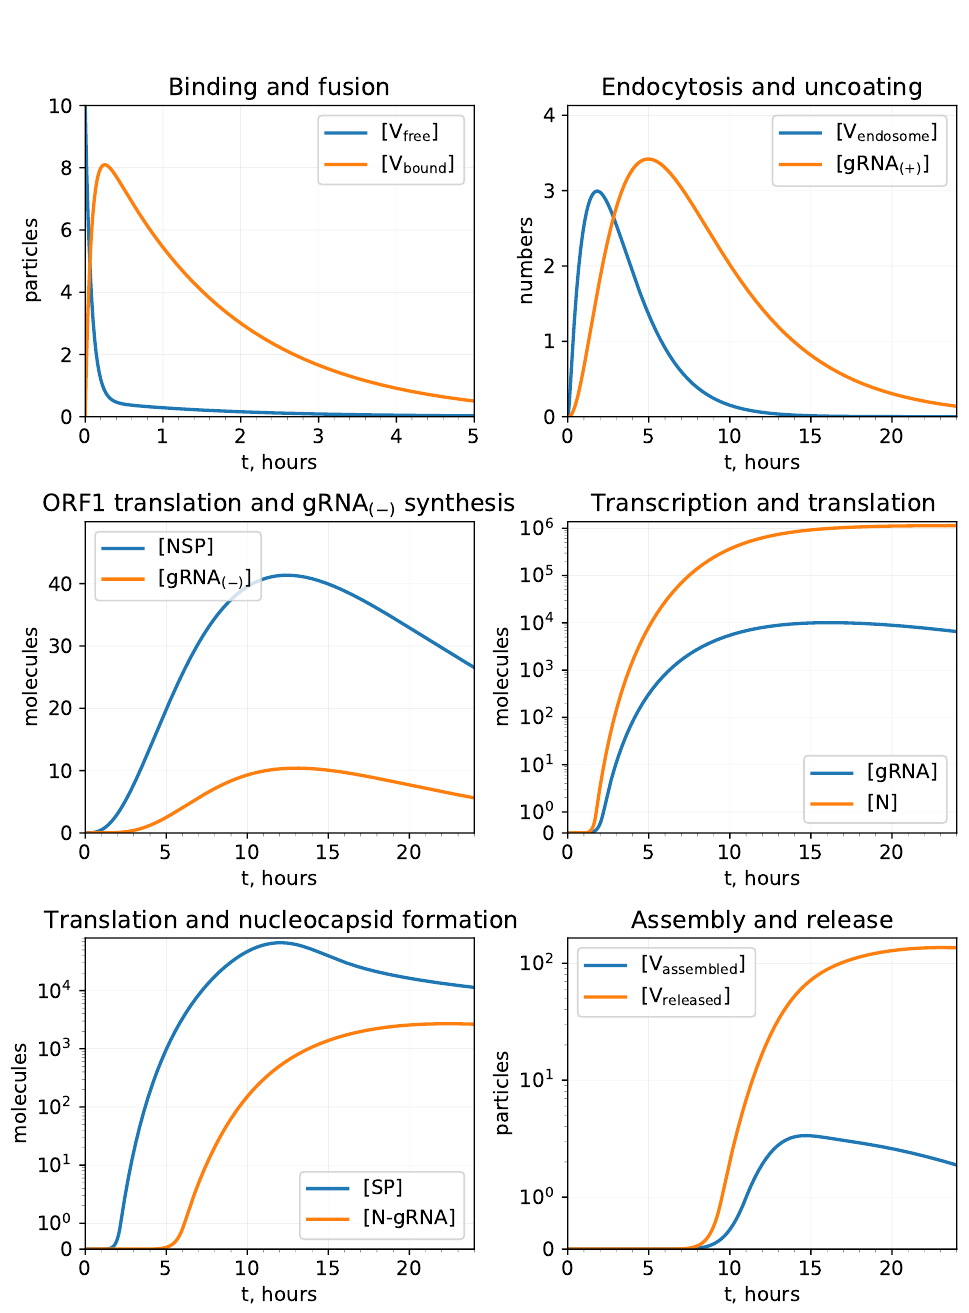
Figure 2. Reference model solution with parameters estimated in Table 2, [ V free ]( 0 ) = 10. It predicts the kinetics of the viral replication intermediates. The upper row describes the cell entry state variables, i.e., ( upper left ) the free virions outside the cell membrane and the virions bound to ACE2, and ( upper right ) virions in endosomes together with single strand positive sense genomic RNA. The middle row specifies the kinetics of negative sense viral genome transcription and translation of non-structural proteins ( middle left ) followed by the positive sense genomic RNA transcription and the translation of N-protein ( middle right ). The bottom row displays the translation of the structural proteins and the ribonucleocapsid molecules formation ( bottom left ) resulting in creation of assembled virions in endosomes and the final release of virions ( bottom right